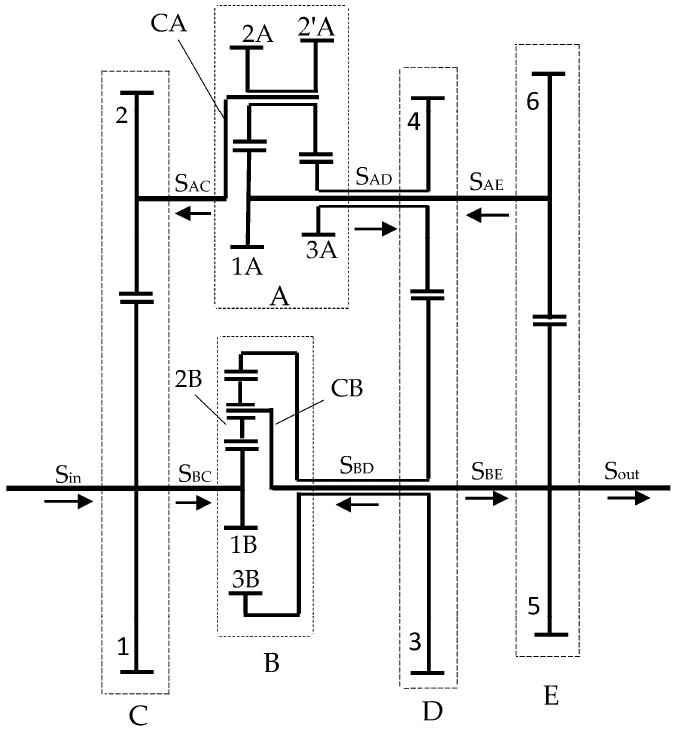
Figure 3. Scheme of the transmission.